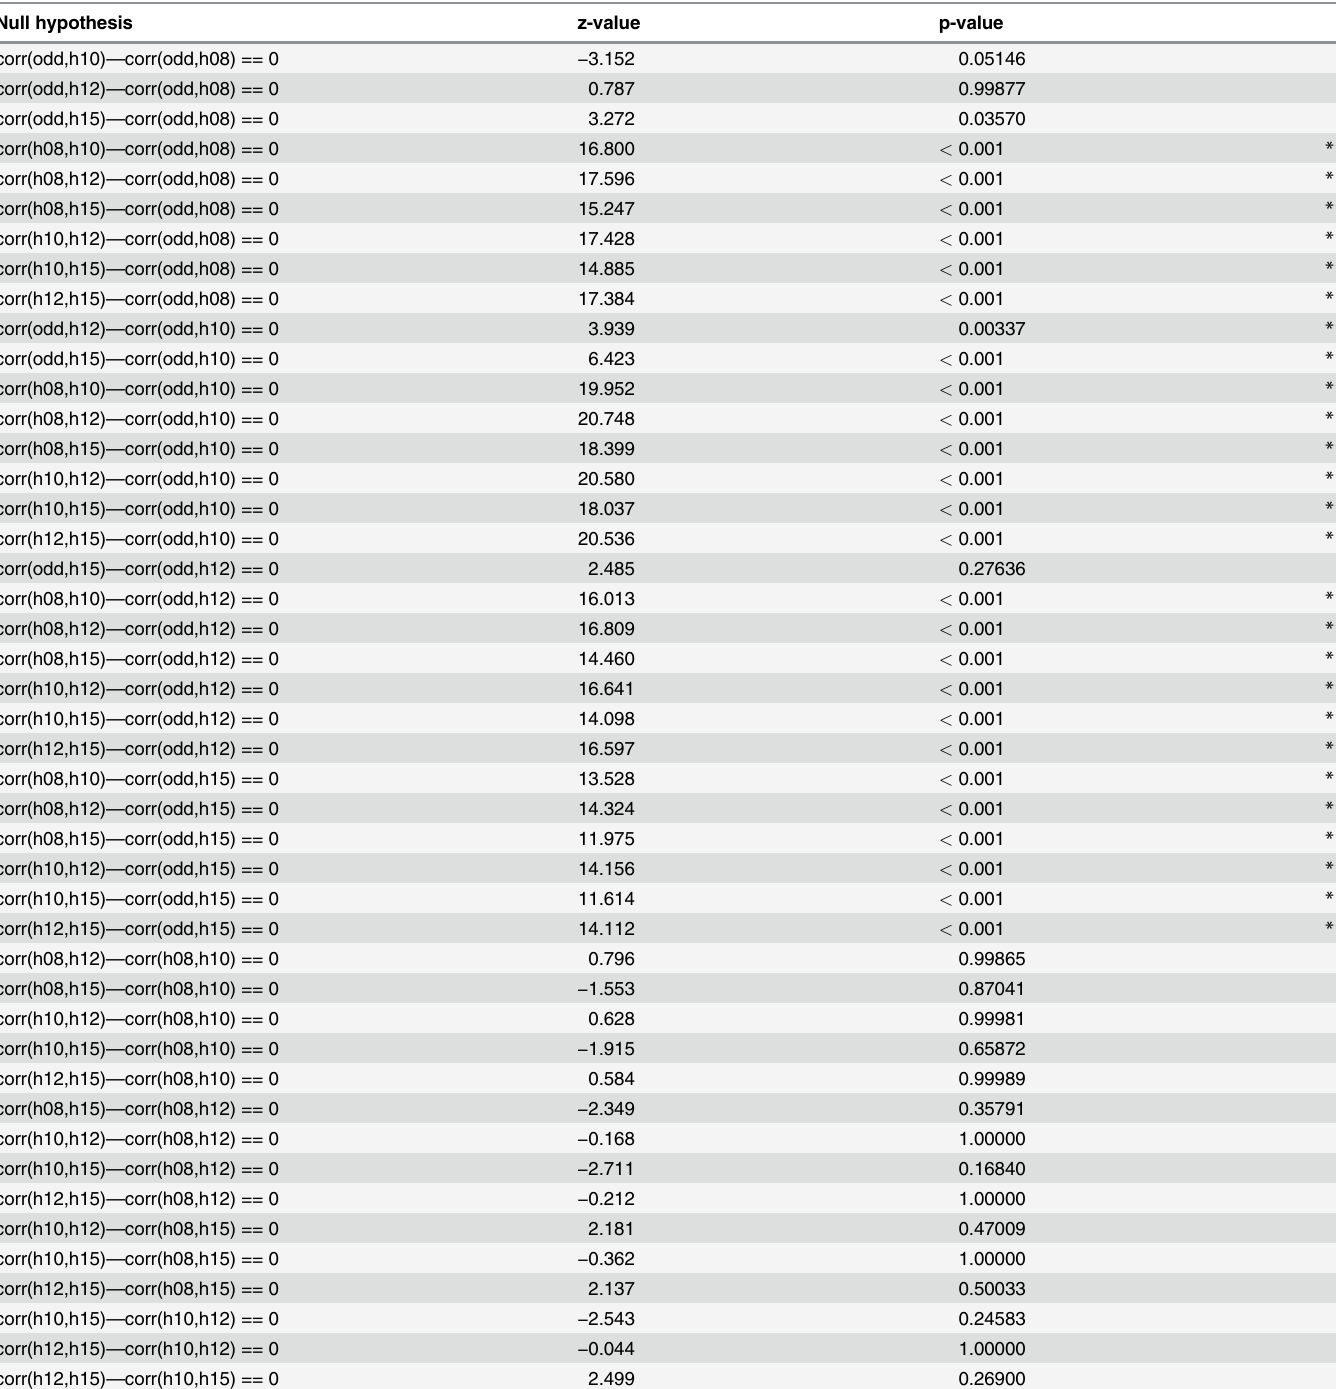
Table 1. Results from the post hoc pairwise comparisons of the linear mixed model built on the correlation data shown in Fig. 5. The first column rep- resents the tested hypothesis; “ odd ” represents the oddball condition while “ h08 ” , “ h10 ” , “ h12 ” and “ h15 ” represent the hybrid condition at 8.57, 10, 12 and 15Hz, respectively. Therefore “ corr(odd, h10) ” represents the correlation between oddball and 10Hz-hybrid ERPs. The first line of the table tests for signifi- cance in the difference between, on the one hand, correlation values between ERPs recorded in the oddball and in the 10Hz-hybrid conditions and, on the other hand, correlation values between ERPs recorded in the oddball and in the 8.57Hz-hybrid conditions. The second and third columns represent respec- tively the test statistic and the associated p-value. the symbol ** denotes statistical significance below